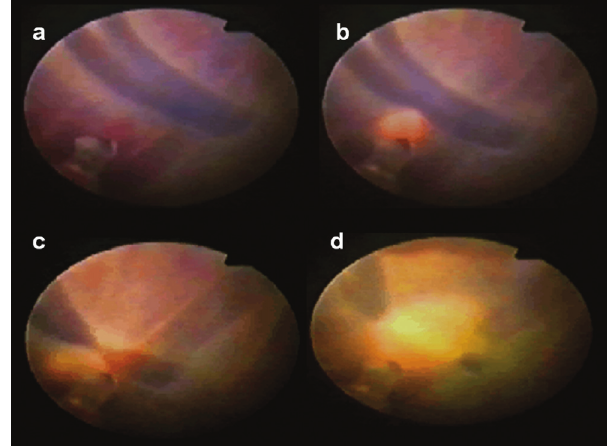
Figure 1 - (a) Fetoscopic view of superficial inter-twin vascular anastomoses in a TTTS stage III pregnancy at 22 weeks of gestation. (b,d) Fetoscopic laser photocoagulation of superficial inter-twin